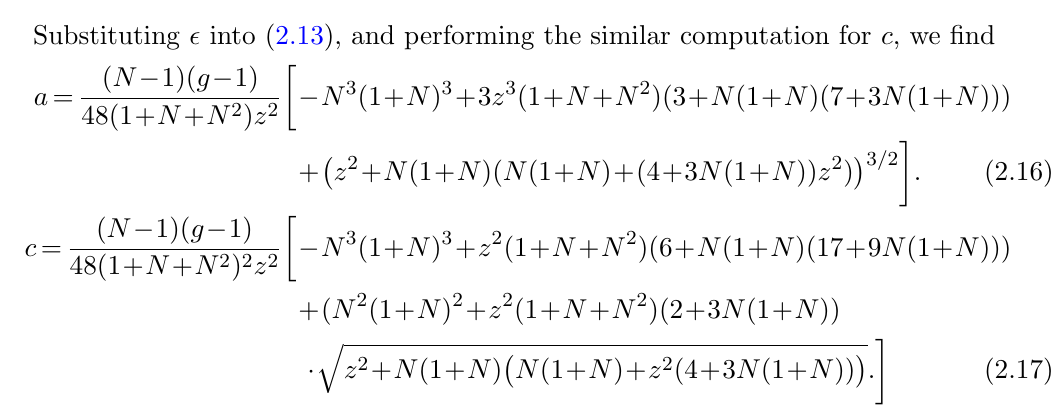
Figure 3. a as a function of the twist z for quivers constructed from 2 g plotted for g = 11 and various N